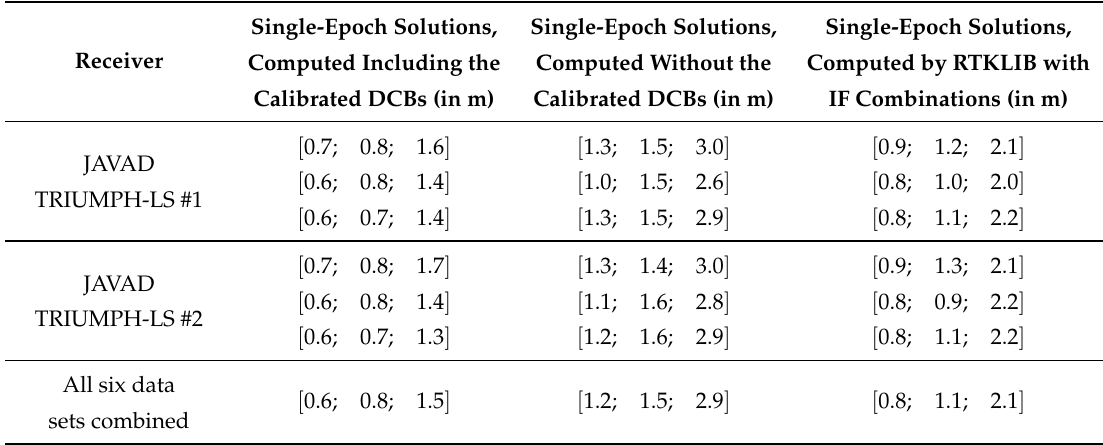
Table 6. RMS Position Error for Single-Epoch Solutions. Results from Three Static 24h Data Sets, Each Collected with Two Receivers on Days 151 (First Line of Each Cell), 153 (Second Line of Each Cell) and 154 (Third Line of Each Cell) of 2018. ENU Coordinate